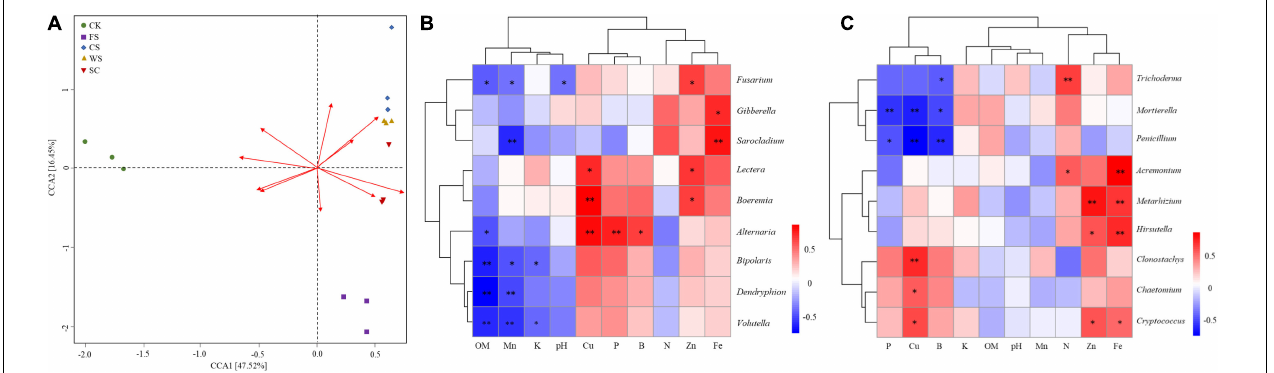
FIGURE 6 | Correlation between soil fungi and soil chemical properties. (A) RDA diagram of soil environmental factors and fungi. Arrow rays represent different environmental factors. The longer the ray is, the greater the impact of the environmental factor. The included angle between the sample fungal community central line and the arrow represents the correlation between the fungal and environmental factors (an acute angle indicates a positive correlation, an obtuse angle indicates a negative correlation, and a right angle indicates no correlation); points of different colors represent different samples; (B) potentially potential pathogen; (C) potentially beneficial fungi. *Indicates a significant correlation ( P < 0.05), **indicates an extremely significant correlation ( P <